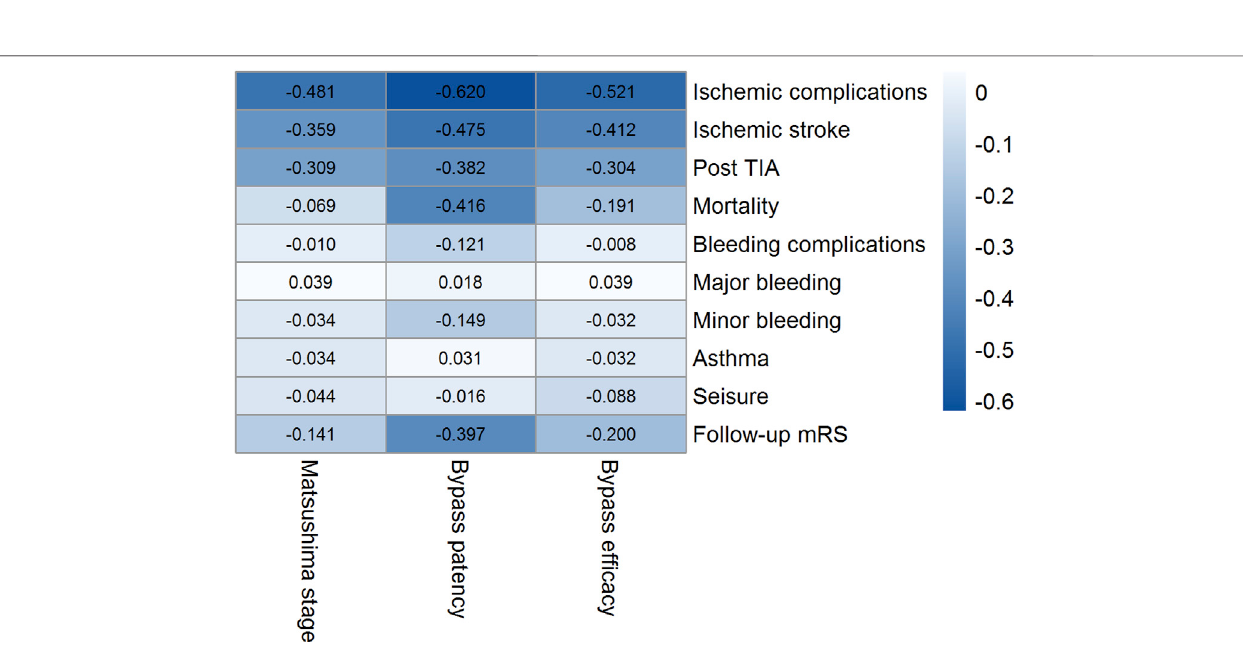
classi fi ed as grades A/B and C, respectively, in the aspirin